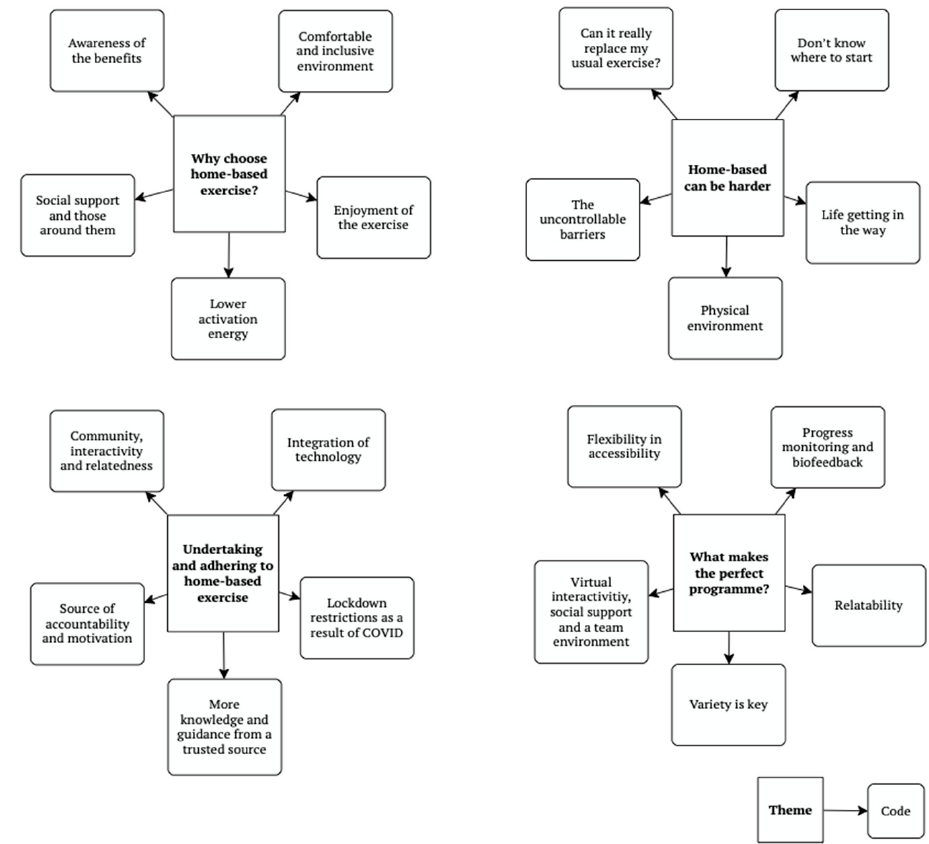
Figure 1. Thematic map of generated codes and themes.